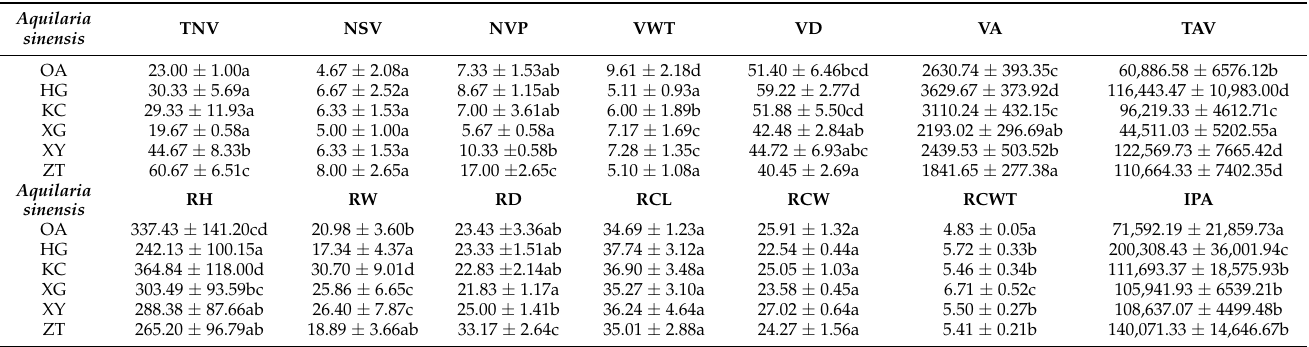
Figure 4. The net photosynthetic rate ( a ), transpiration rate ( b ), intercellular CO 2 concentra- tion ( c ) and stomatal conductance ( d ) in leaves of OA and Qi-Nan trees, at the light intensity of 1200 µ mol · m − 2 · s − 1 . Different letters denote significant ( p < 0.05) differences among OA and five Qi-Nan clones in a one-way ANOVA, the bar represents standard deviation ( n = 5), “Pn” net photosynthetic rate; “Tr” transpiration rate; “Ci” intercellular CO 2 concentration; “Cond” stom- atal conductance. Table 2. Differences in xylem anatomical characteristics between five Qi-Nan clones and